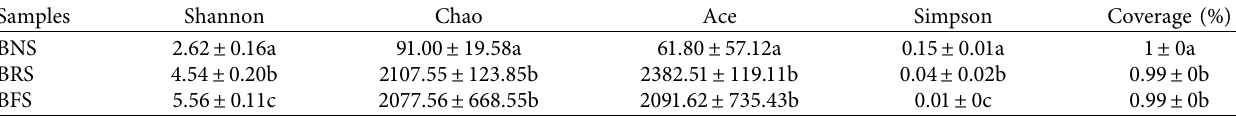
Table 13: Effects of bryophytes on bacterial community diversity index in electrolytic manganese slag areas. Samples